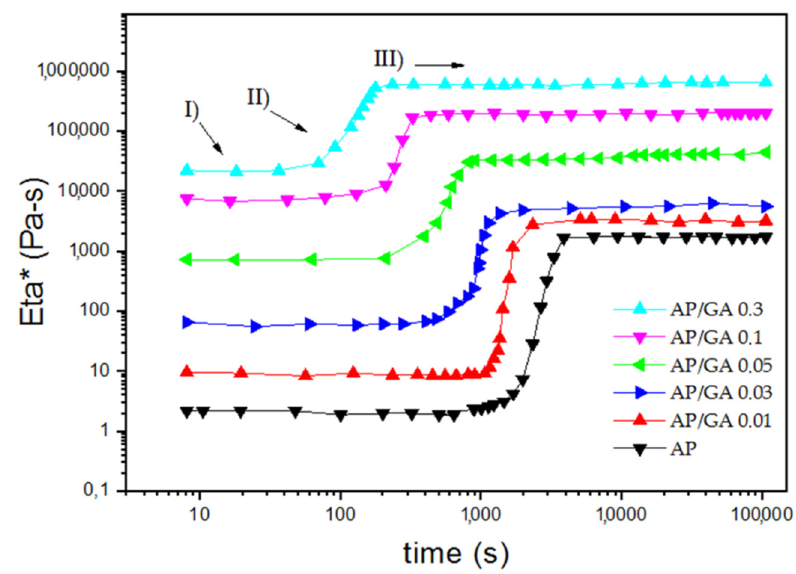
Figure 7. Complex viscosity ( η *) vs. time of AP and AP/GA samples.